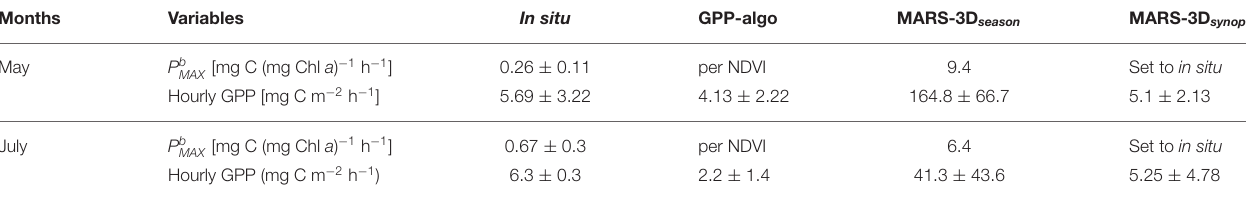
TABLE 2 | Measured and simulated maximum photosynthetic capacity ( P b MAX ) and hourly GPP in May and July 2015.